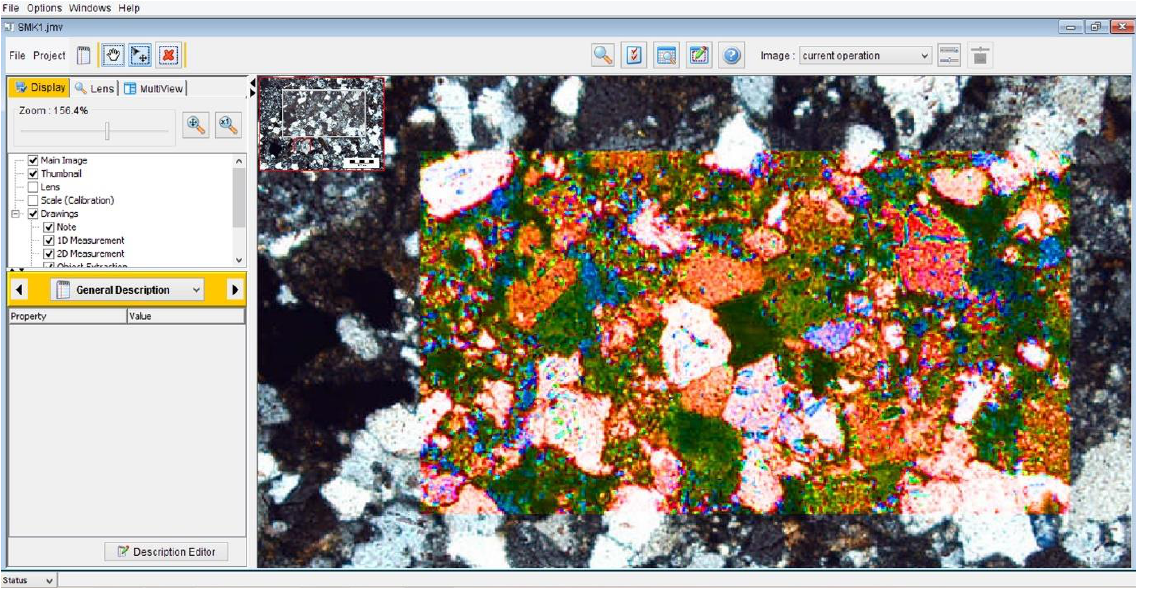
Figure 7. JMicroVision (v1. 27) software environment for measuring TC of the rocks. Table 4. Texture coefficient derivations for the rocks.